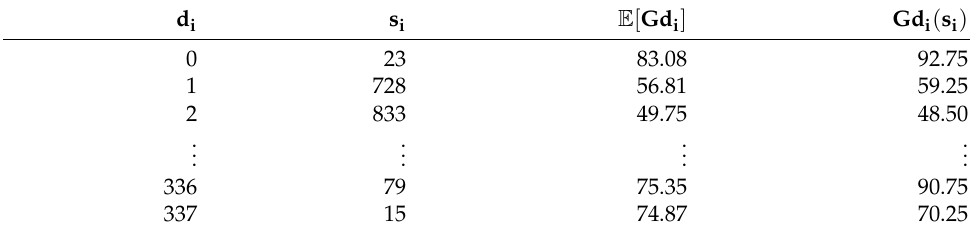
Table 6. Discussion table—random student’s Grades against Discussion’s Grade